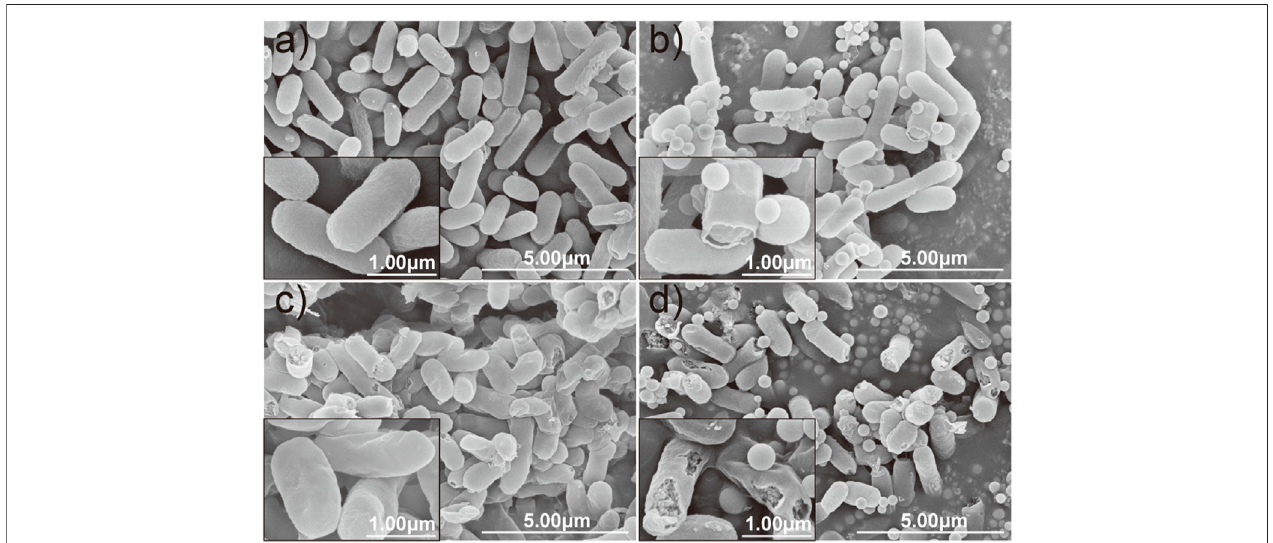
FIGURE5 | CLSM imagesof E. coli before and after treatment with SiO 2 NPs, gati fl oxacin, and GAT-SiO 2 NPs. Live bacteria werestained with green fl uorescence (SYTO ® 9). Dead bacteria were stained with red fl uorescence (PI).